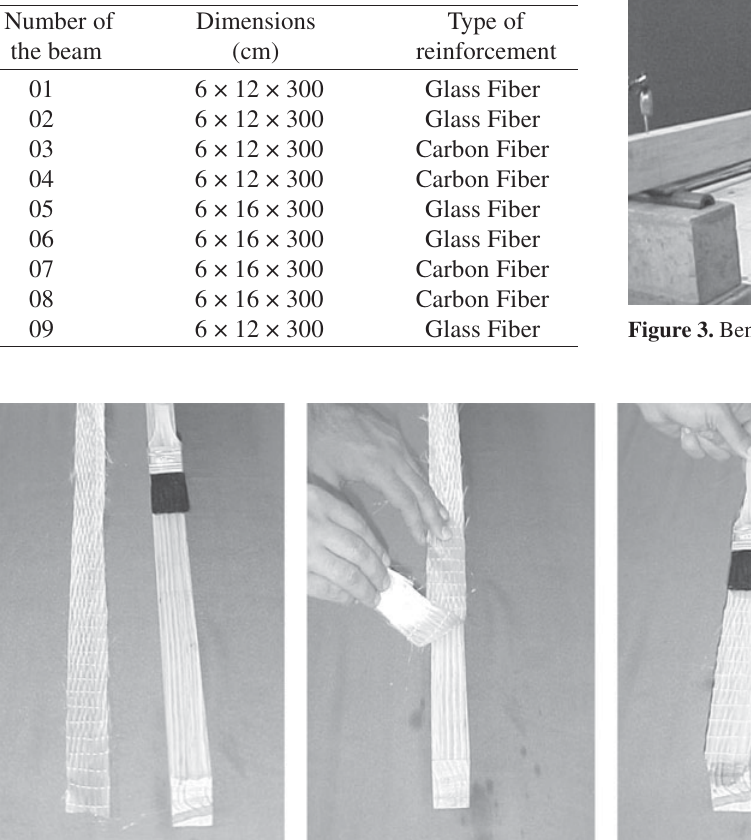
Table 1. Information of the wood beams.